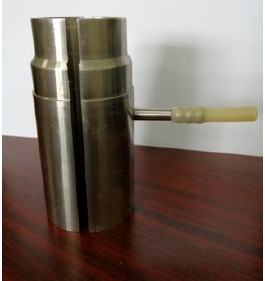
Figure 2. The metal mold for the construction of the specimens.